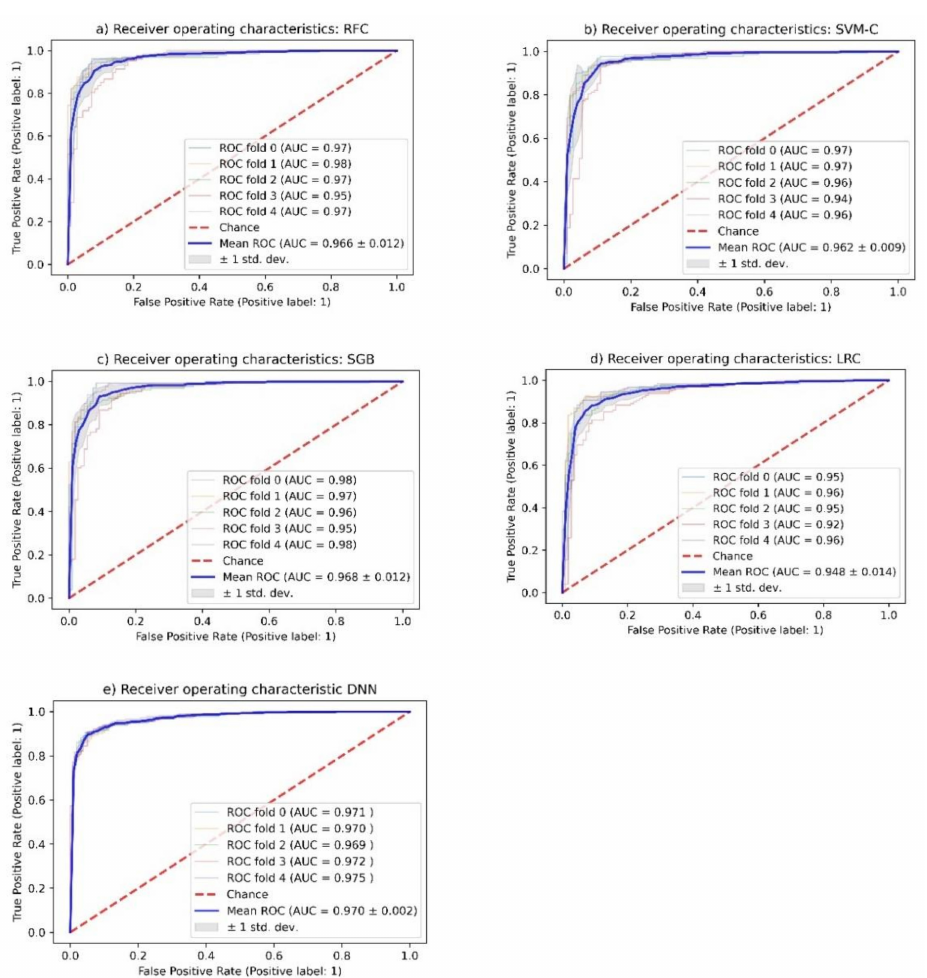
Figure 4. Receiver operating characteristic (ROC) of the investigated methods. ( a ) Random Forest classifier, ( b ) Support Vector Machine classifier, ( c ) Stochastic Gradient Boosting classifier, ( d ) Logistic Regression classifier, and ( e ) Deep Neural Network